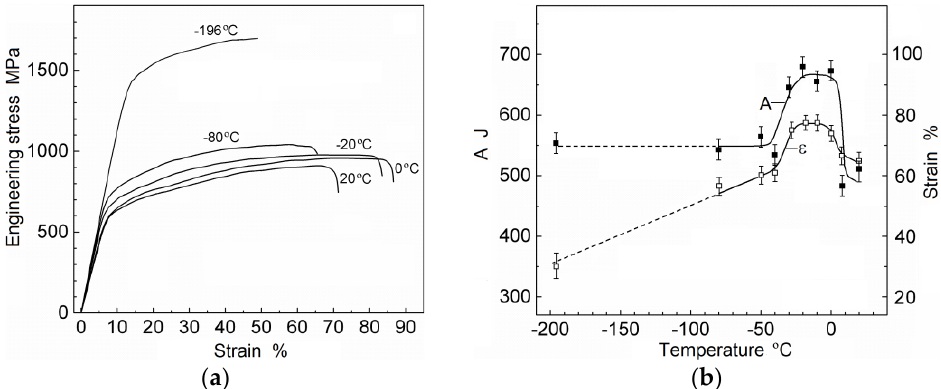
Figure 1. The engineering ( σ – ε ) tensile curves for Cr-Mn-N steel at various testing temperatures ( a ); the temperature dependences of the strain and work of a plastic strain ( b ).